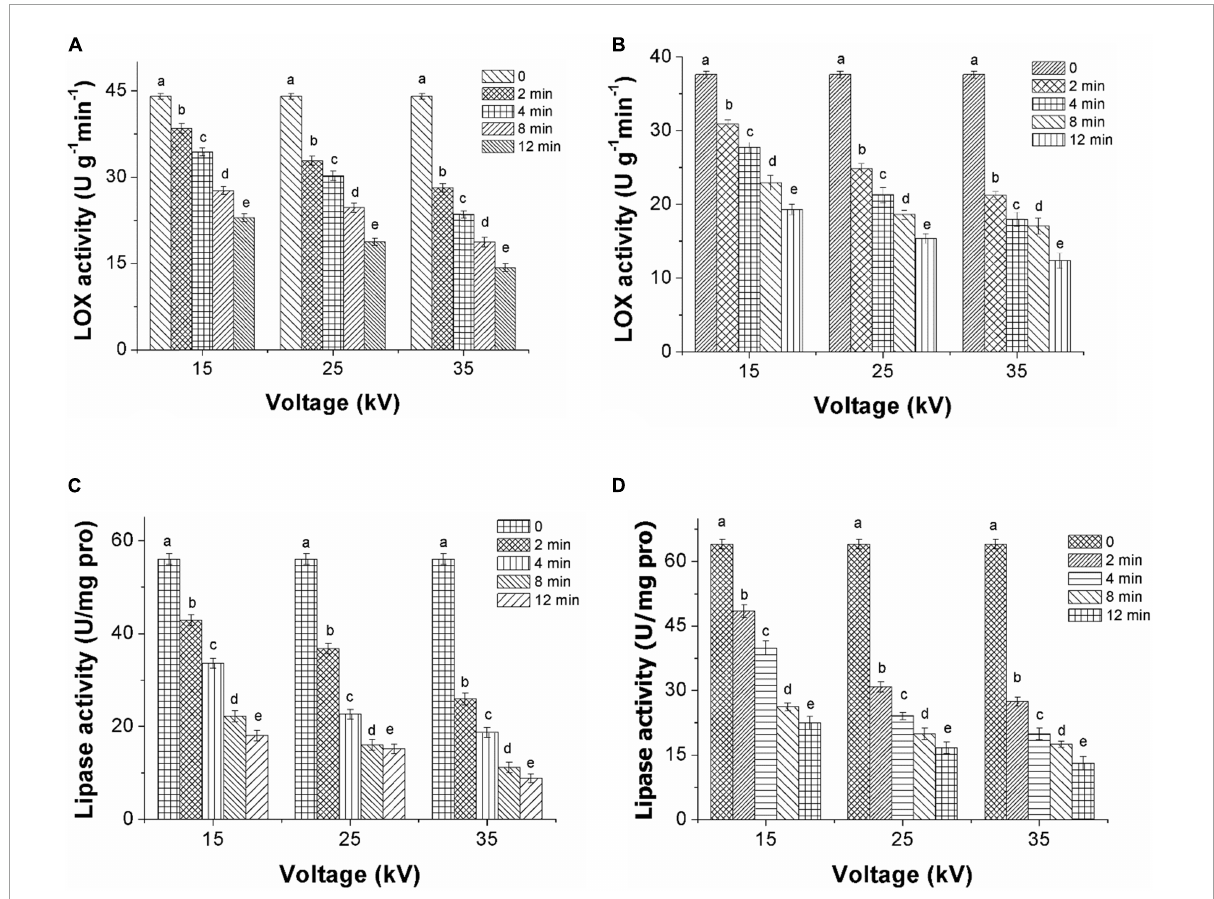
FIGURE3 Decrease of LOX and lipase activity of foxtail millet induced by DBD-ACP. (A,C) Mizhi. (B,D) Ansai.